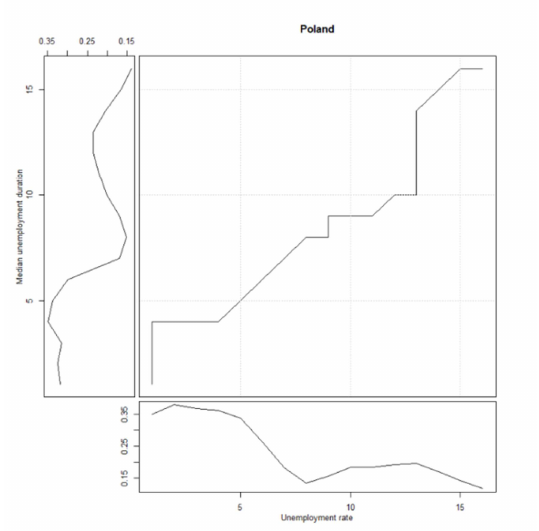
Figure 8. Alignment plots for the unemployment rate and lagged median unemployment duration for Poland